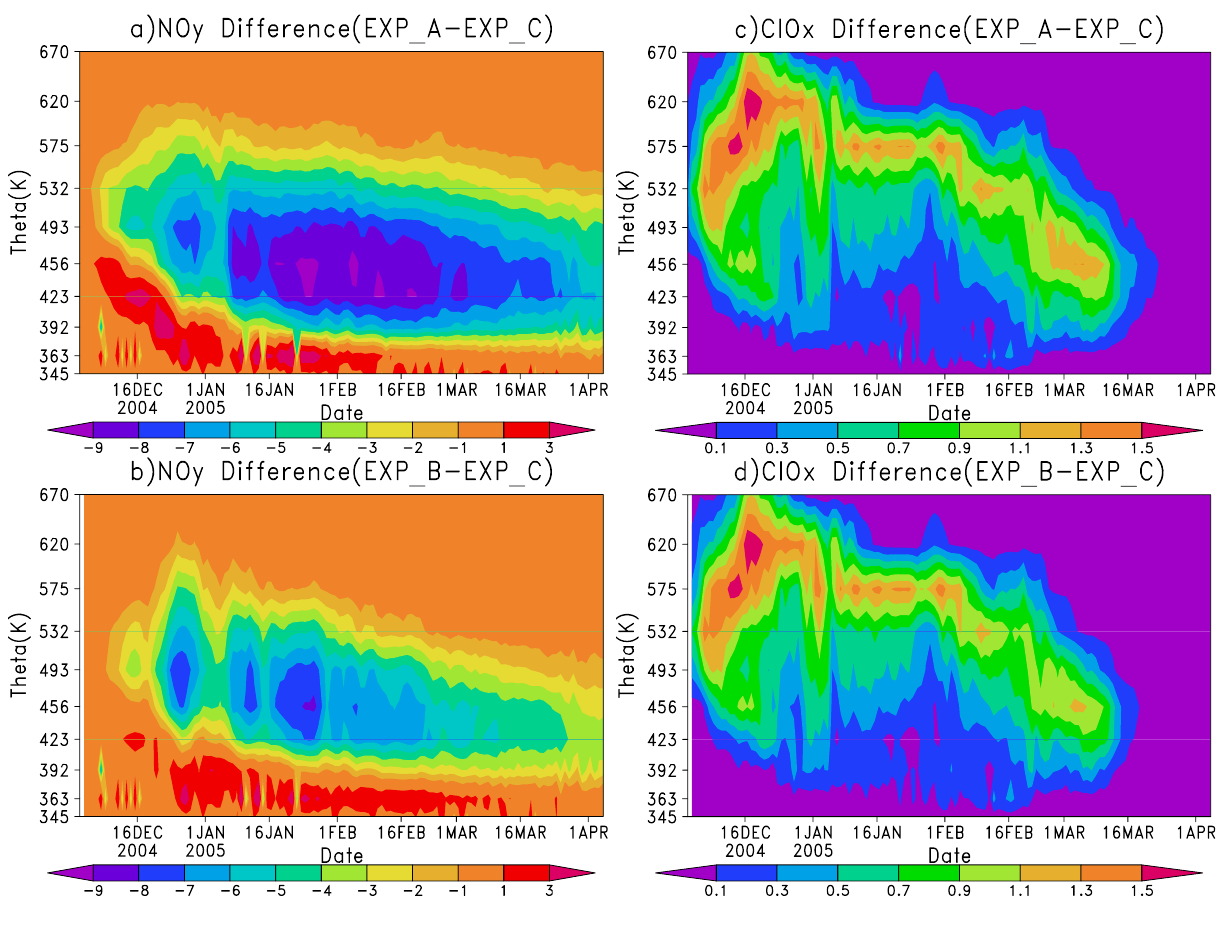
Fig. 6. Difference in vortex-averaged NO y and ClO x (ppbv) as a function of time and potential temperature for SLIMCAT full chem- istry simulations using the equilibrium (EXP A) and DLAPSE (EXP B) PSC schemes with respect to the SLIMCAT simulation without denitrification (EXP C) for Arctic winter